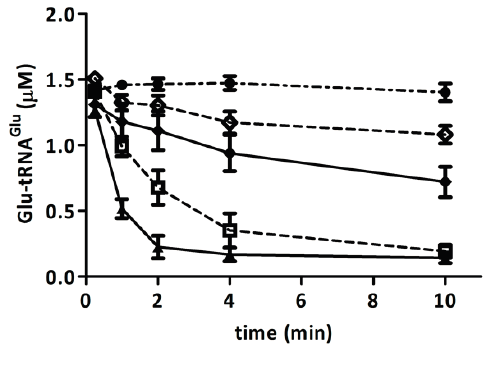
Figure 6. Competition between GluTR and EF-Tu for Glu-tRNA Glu . The deacylation of Glu-tRNA 2Glu catalyzed by GluTR (0.5 µM) in presence of EF-Tu is shown. Deacylation was monitored when GluTR was untreated ( ▲ , ♦ ) or previously treated ( □ , ◊ ) with 300 μ M H 2 O 2 and in the presence of EF-Tu, treated ( ◊ ) or untreated ( ♦ ) with 300 μ M H 2 O 2 . The deacylation of Glu-tRNA 2Glu in the absence of GluTR or EF-Tu was used as a control ( ● ). Each curve is the mean of three experimental